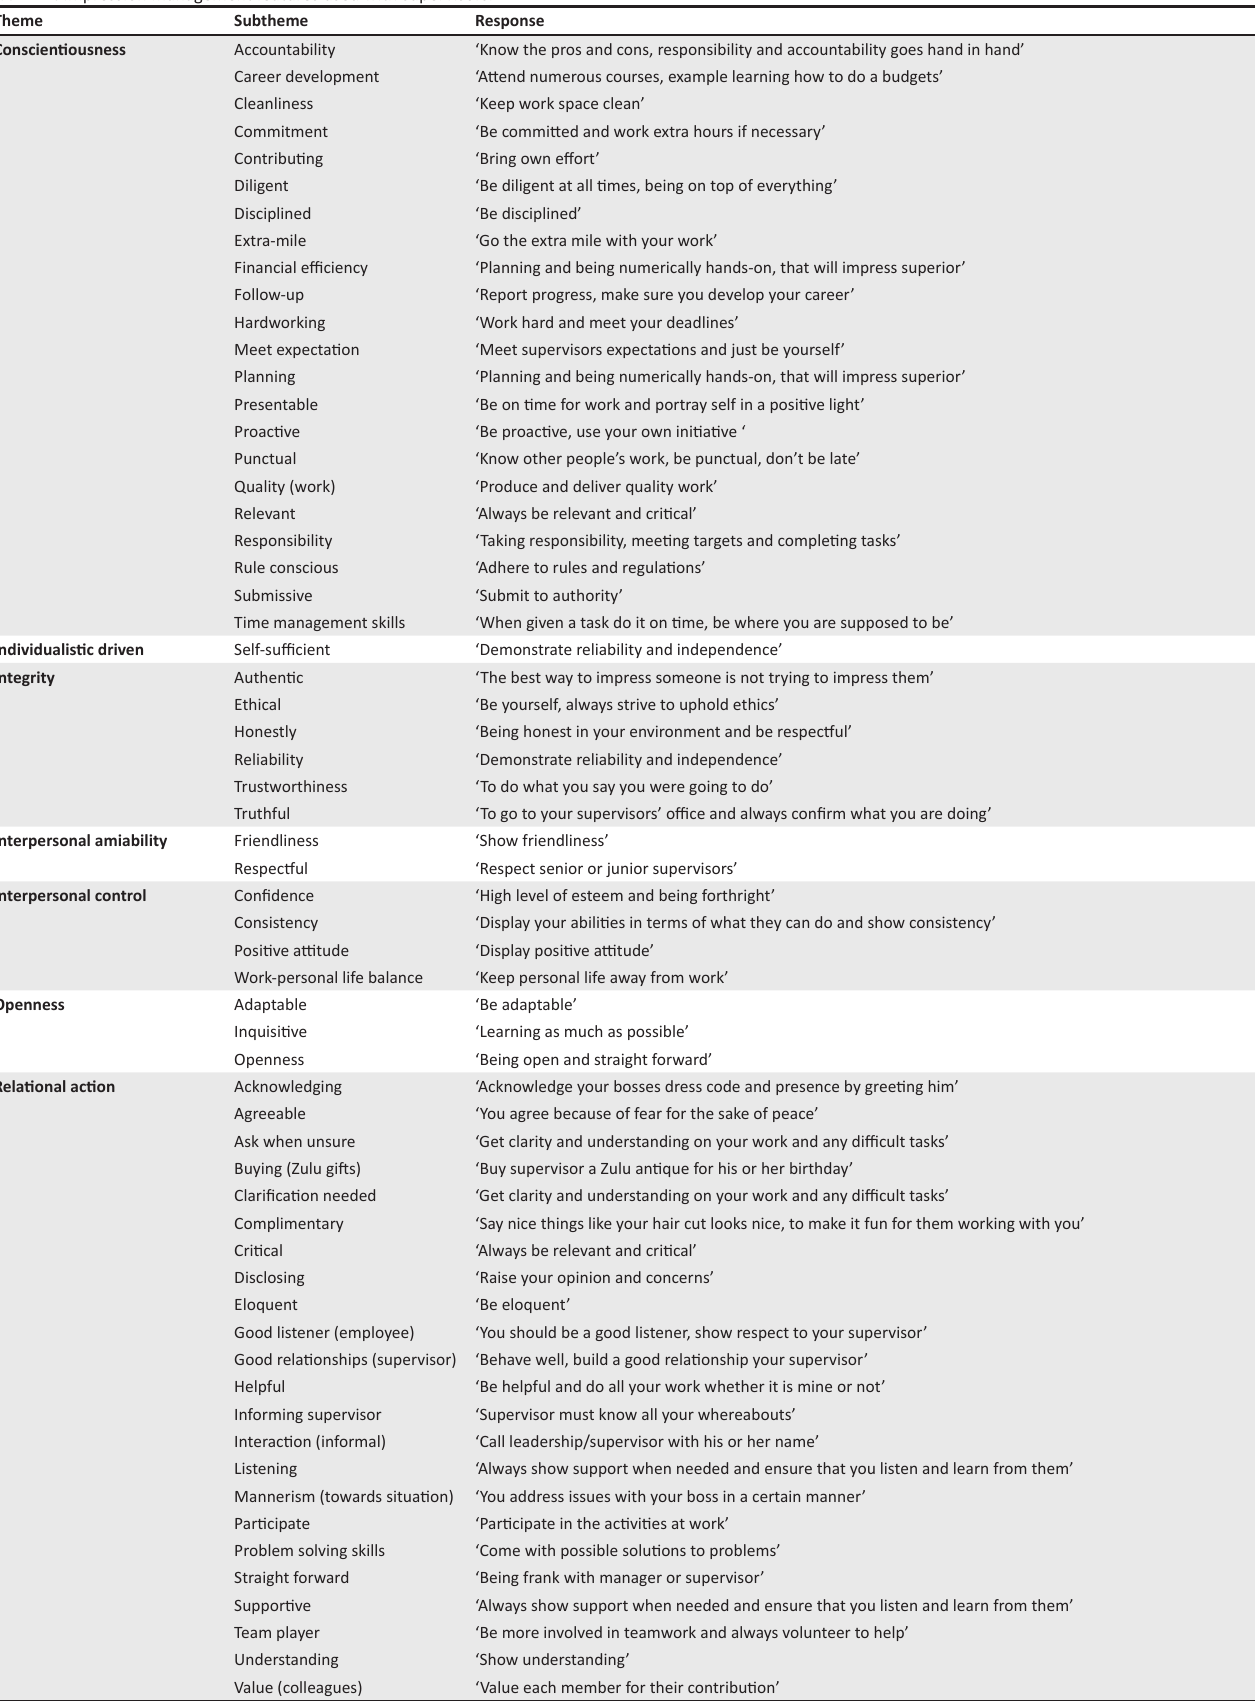
TABLE 2: Impression management features used with supervisors. Theme Subtheme Response